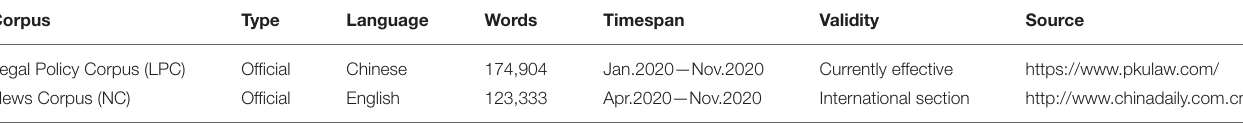
TABLE 1 | Basic information of the two corpora.